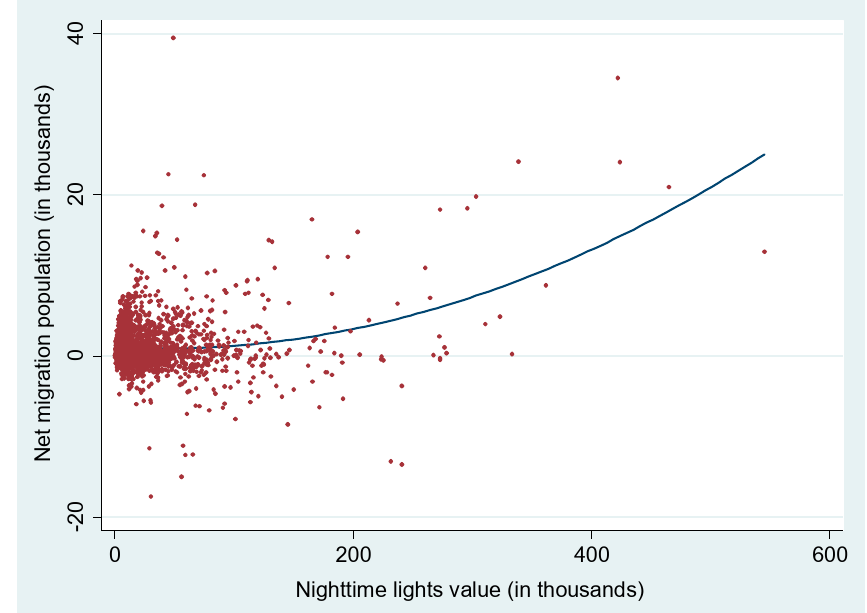
Figure 2. Quadratic plot of net migration population and nighttime lights.